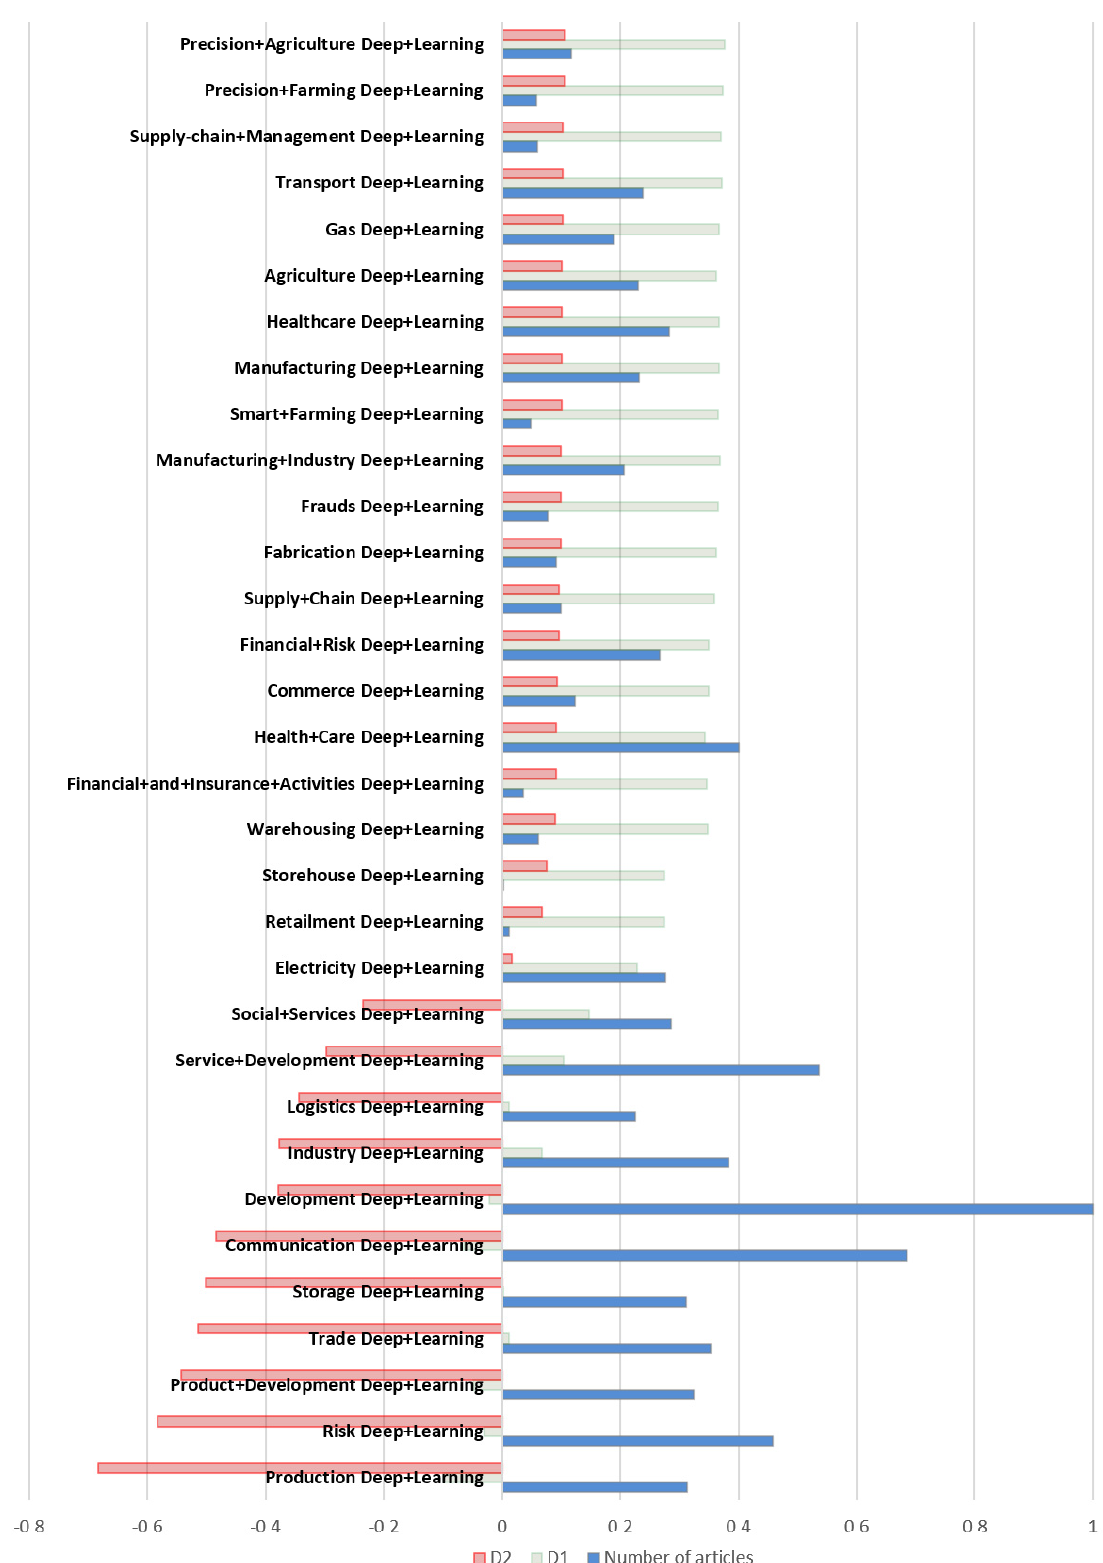
Figure 12. Speed D1 and acceleration D2 of the increase in the number of scientific publications in the applied domains of deep learning. Source: generated by the authors.